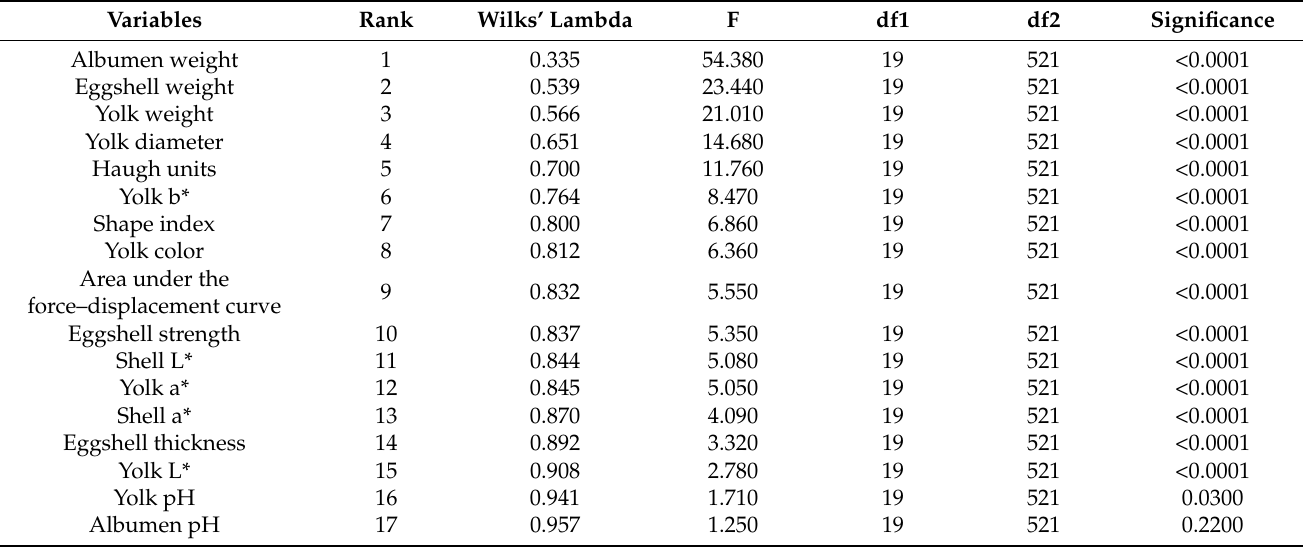
Table 7. Results for the tests of equality of group means to test for difference in the means across egg groups once redundant variables have been